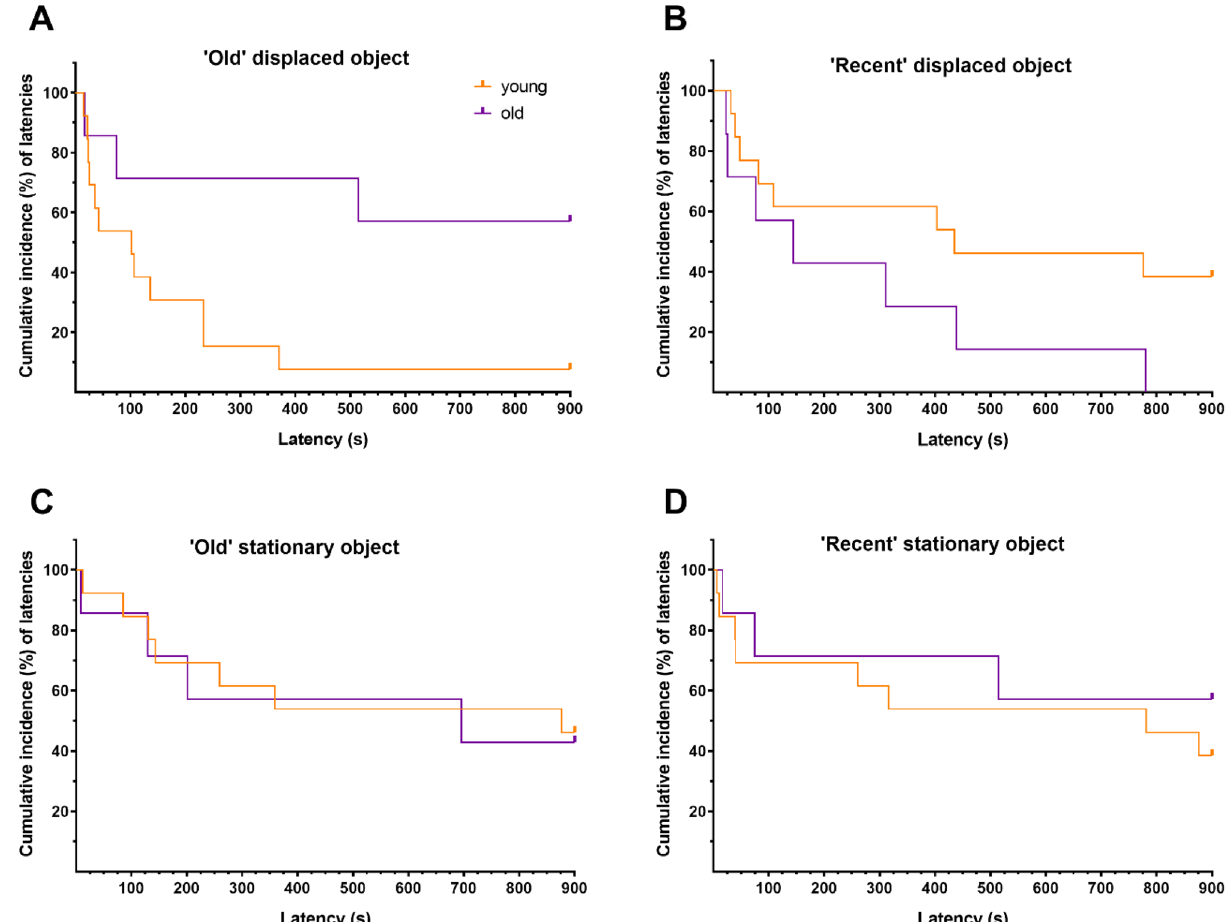
Figure 4. Latency. Cumulative incidence of latencies (%) over the course of the trial (900 s) to reach and explore the ‘old’ displaced object ( A ), ‘recent’ displaced object ( B ), ‘old’ stationary object ( C ) and ‘recent’ stationary object ( D ), by the different groups (young, orange; old,